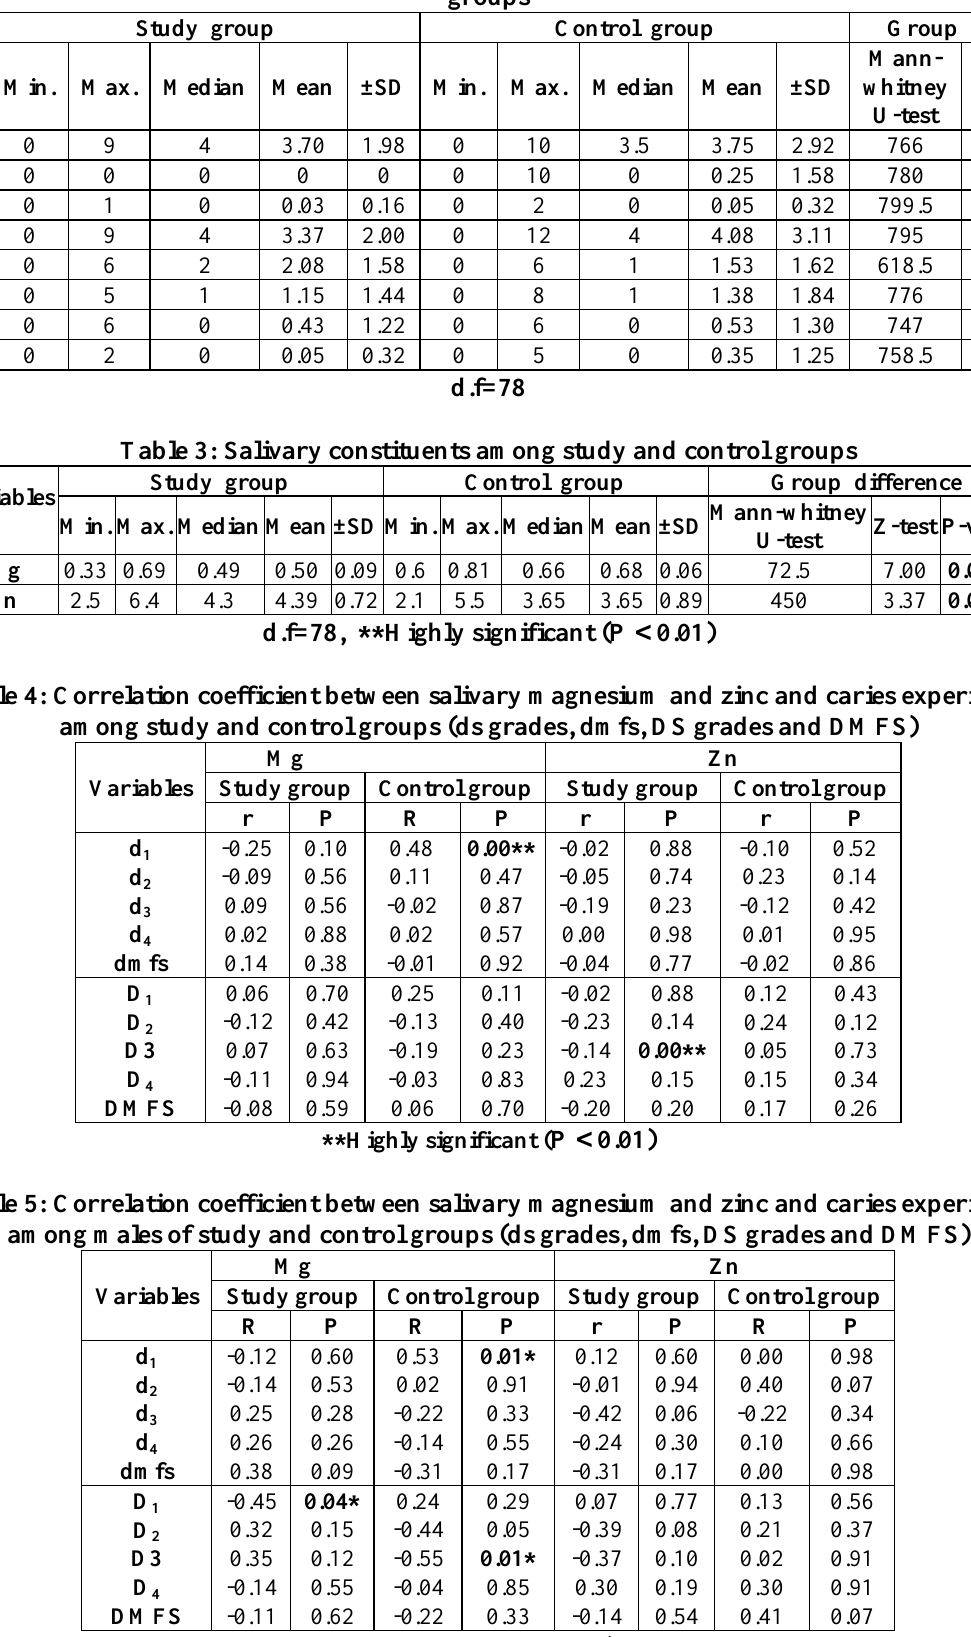
Table 2: Caries experience and caries severity for permanent dentition among study and control